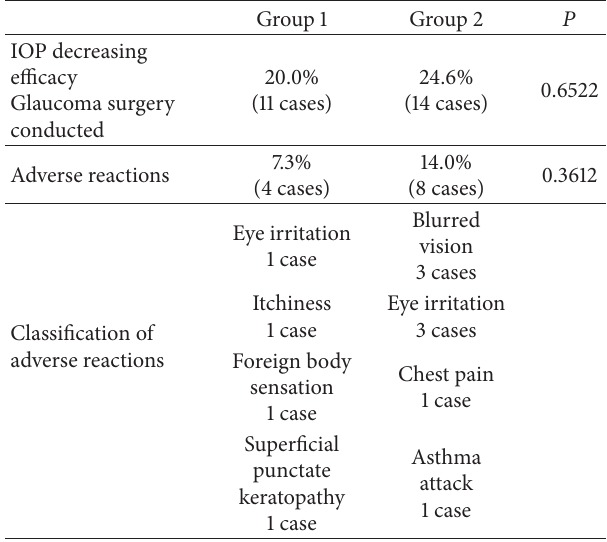
Table 2: Cases discontinued after the switch to fixed-combination eye